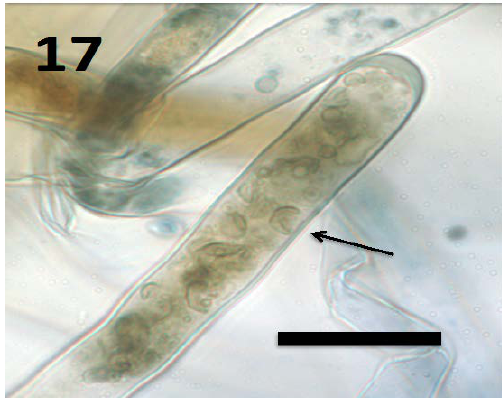
Figure 16. Root hair tip of Amaranthus viridis seedling showing yeast cells of Aurobasidium pullulans (arrows) exiting from the tip of the hair and brown staining walled yeast cells within the hair (bar = 15 µm; stained with 3,3-diaminobenzidine followed by aniline blue).